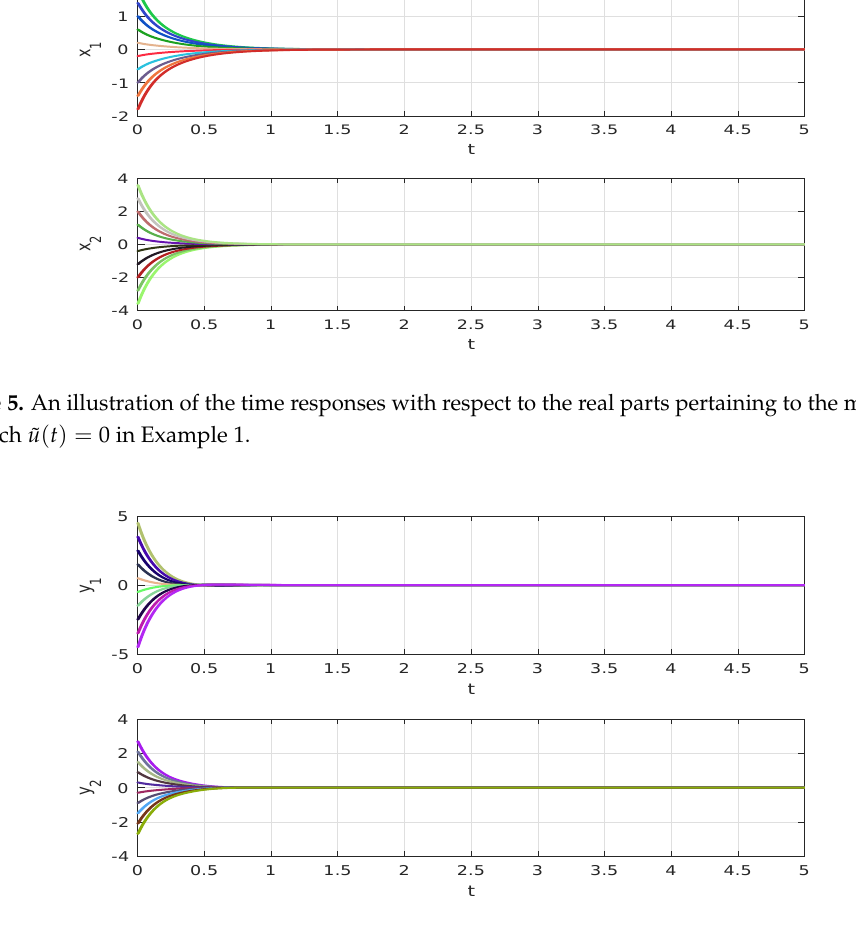
Figure 6. An illustration of the time responses with respect to the imaginary parts pertaining to the model in (20), in which ˜ u ( t ) = 0 in Example